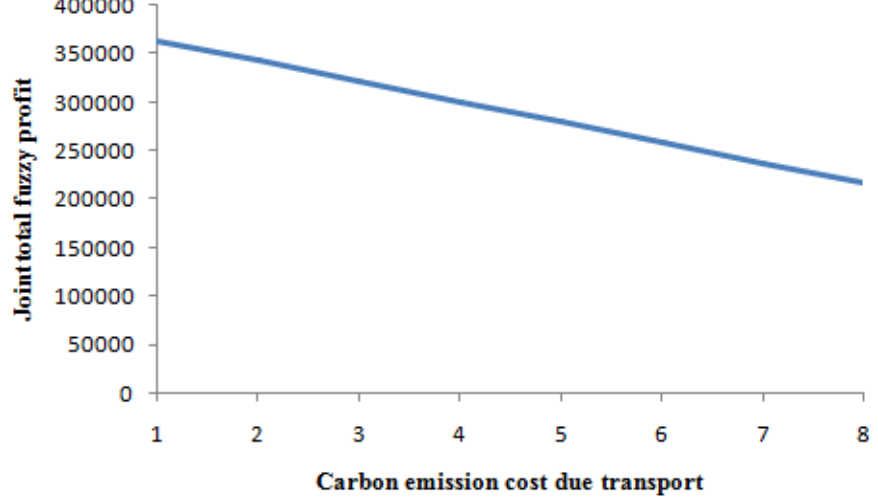
Figure 12. The carbon emission cost due to transportation vs. the total fuzzy profit.